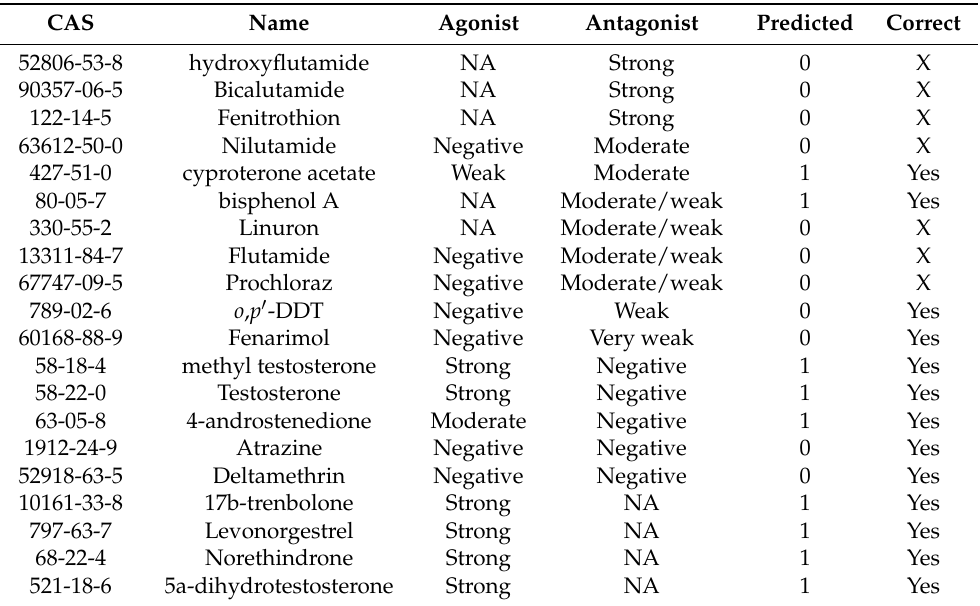
Table 3. AR pathway in vitro reference compounds and their predicted class according to Proce- dure 13